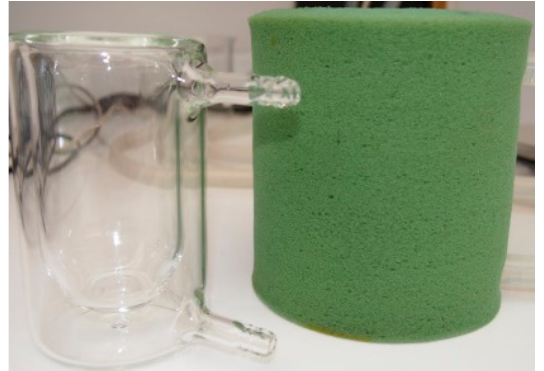
Figure 2. A homemade double walled titration vessel ( left ); a polyurethane jacket ( right ).